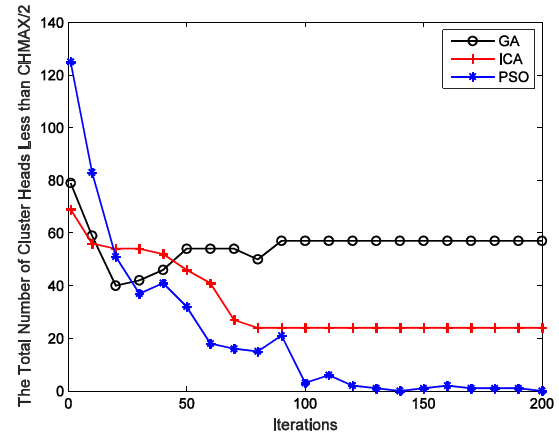
Figure 10. Total number of CHs less than ½×CH max .